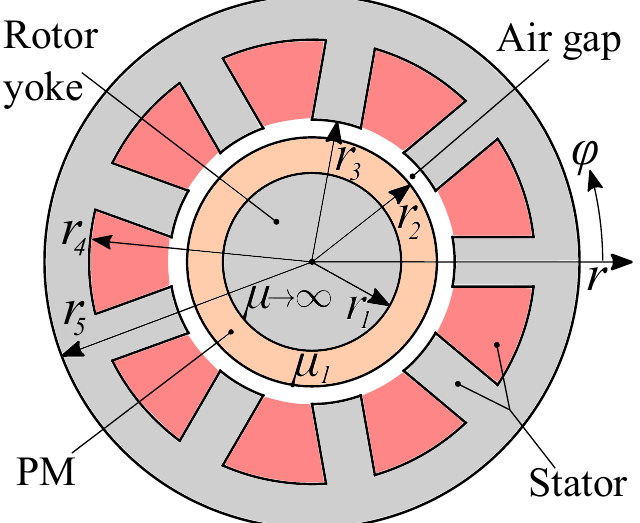
Figure 1. Geometry and parameters of the